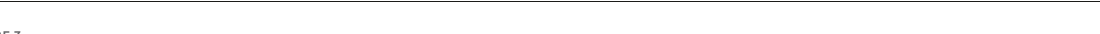
FIGURE3 Landscape of the TME and the immune infiltration of different subgroups. (A) Tumor mutation burden of copper-related proteins. Mutated genes (rows, top 13) are ordered by mutation rate, and samples (columns) are arranged to emphasize mutual exclusivity among mutations. The right shows the mutation percentage, and the top shows the overall number of mutations. The color coding indicates the mutation type. (B,C) Significantly mutated genes in the mutated GBM samples of different subgroups. Mutated genes (rows, top 20) are ordered by mutation rate. (D) Correlation analysis between risk score and total mutational burden. (E) Total mutational burden of the high-risk and low-risk groups. (F) Differential analysis of immune-related biological processes in the high- and low-risk groups. (G,H) The proportions of TME cells in the high- and low-risk groups in TCGA cohort. (I,J) The IRGPI group based on different grades and immune subtypes in the high- and low-risk groups. (K,L) TIDE and dysfunction scores in the high-risk and low-risk groups. The scores between the two groups were compared using the Wilcoxon test (ns, not significant; ** p < 0.01; *** p <